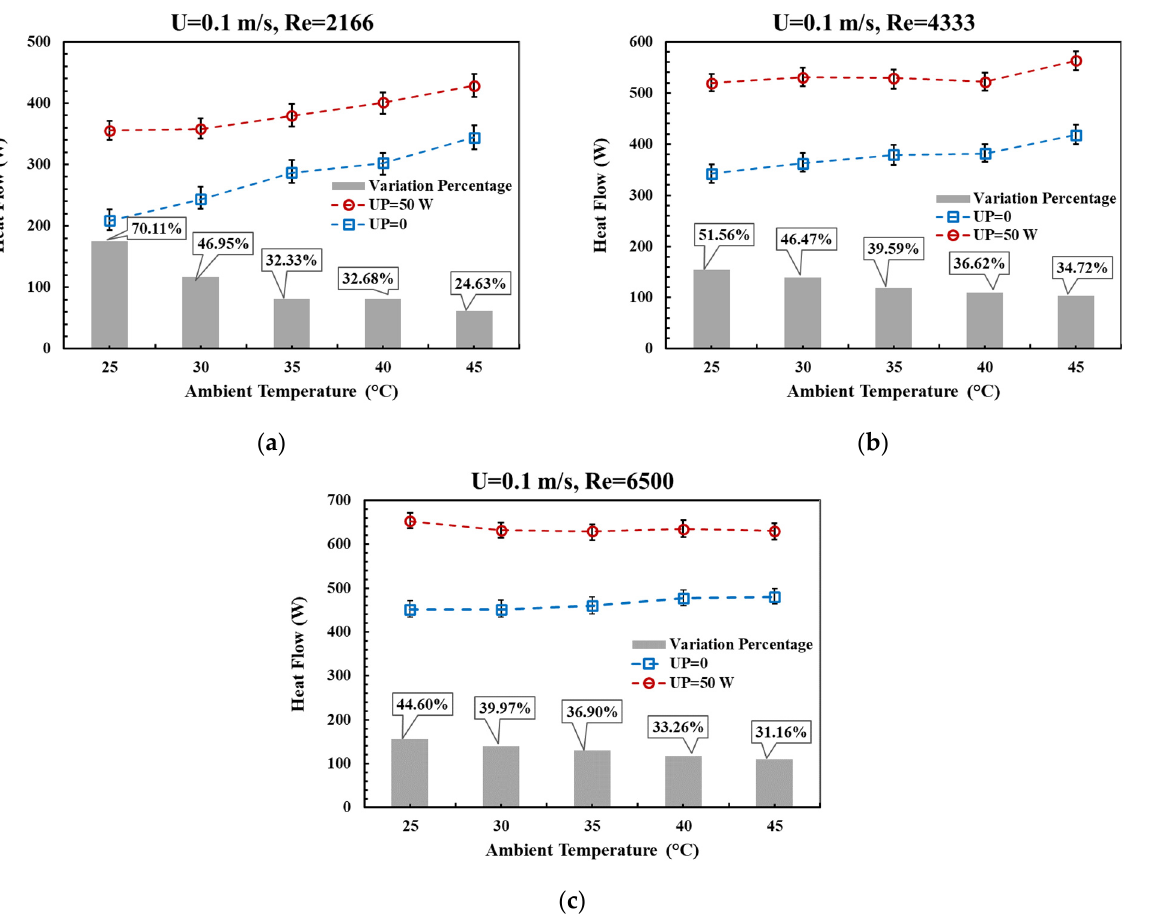
Figure 7. The variations of heat flow against ambient temperature at U = 0.1 ( m/s ) and Reynolds numbers of ( a ) Re = 2166, ( b ) Re = 4333, ( c ) Re = 6500. The results are presented in a no-vibration state (UP = 0) and in the presence of vibration with ultrasonic power of 50 Watts (UP = 50 (W)).